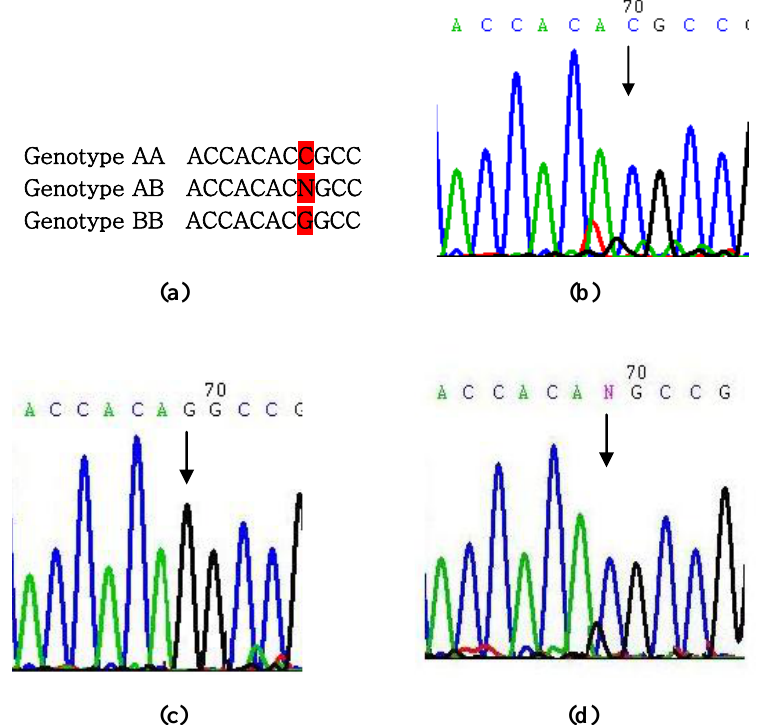
Figure 2. Nucleotide sequence comparison of the PCR products in Cashmere goat; (a) BLAST results of the nt sequence of three genotypes in this study with nt sequence in GenBank; (b) nt sequence of genotype AA (arrow’s position is consistent with nt sequence in GenBank); (c) and (d) nt sequence of genotype AB and BB (the arrow points to the mutation site).